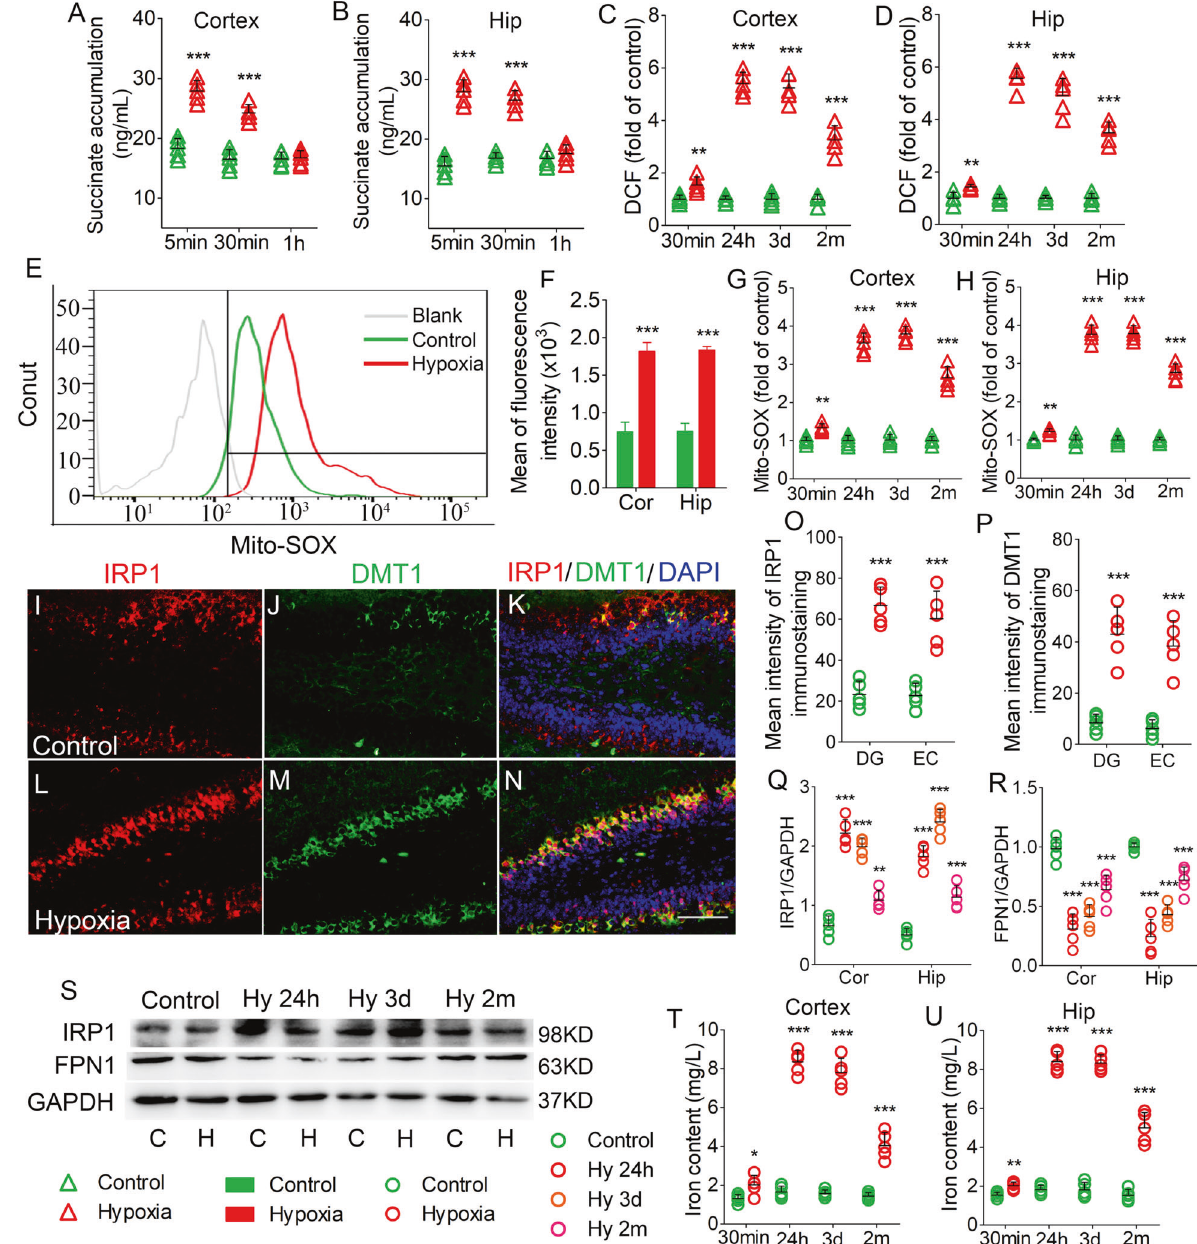
Fig. 1 Increased levels of succinate, DCF, mito-SOX, and iron after hypoxia treatment. Increased levels of succinate ( A , B ), DCF level ( C , D ), and mito-SOX ( G , H ) in the hippocampus and cortex in hypoxia-induced seizure. E , F Flow cytometry-based quanti fi cation of hippocampal mito-SOX level. I – N Increased immunoreactivity of IRP1 (red), DMT1 (green) in the DG region after hypoxia. Blue, DAPI. O , P Quanti fi ed changes of IRP1 and DMT1 in the EC and DG. Bar = 50 μ m. Q – S Levels of IRP1 and FPN1 in the hippocampus and the cortex estimated using western blotting. n = 5/group. T , U Levels of iron ( n = 5 per time point). * P < 0.05, ** P < 0.01, and *** P < 0.001, all compared with controls (One-way ANOVA). AICAR reversed the increased mitophagy levels, neuronal (Fig. 7C and D), and mito-SOX (7E-H) in the hippocampus and cortex. injury, and cognitive de fi cits induced by hypoxia treatment Moreover, results of immunohistochemistry con fi rmed that AICAR A signi fi cantly reduced fl uorescence intensity of LC3B/TOMM20 in treatment decreased immunoreactivity of DMT1 and IRP1 in the DG the hippocampus and cortex due to AICAR treatment was and EC (Fig. 7I-P), as well as in the other subregions of hippocampus observed (e.g. DG and EC; Fig. 8A – H; Supplementary Fig. 4C, D). and PC (data not shown). Additionally, western blotting analysis Western blotting analysis con fi rmed reduced LC3B levels in AICAR- revealed that AICAR-treated mice showed decreased IRP1 levels treated mice compared to saline-treated mice (Supplementary Fig. (Fig. 7Q and S) and increased FPN1 levels (Fig. 7R and S). 4A, B). Moreover, AICAR-treated mice showed decreased activated Additionally, AICAR-treated mice showed decreased iron levels than caspase-3 levels (Fig. 8I, K) and increased caspase-3 levels that in saline-treated mice (Fig. 7T and U).